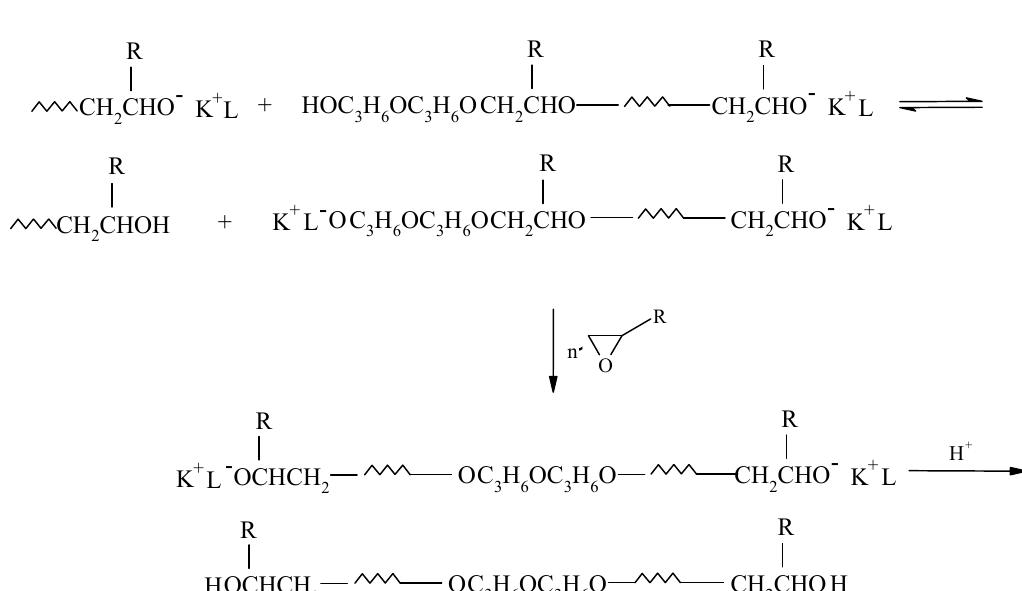
Figure 9. MALDI-TOF spectrum of PPGE-diol (11) synthesized with